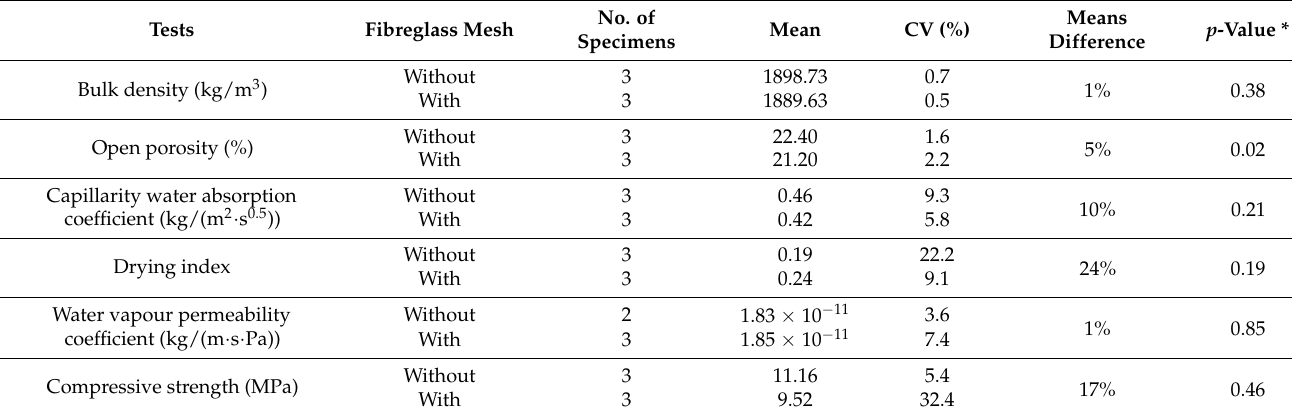
Table 6. Hydraulic lime mortar applied to the hollow ceramic brick substrate.